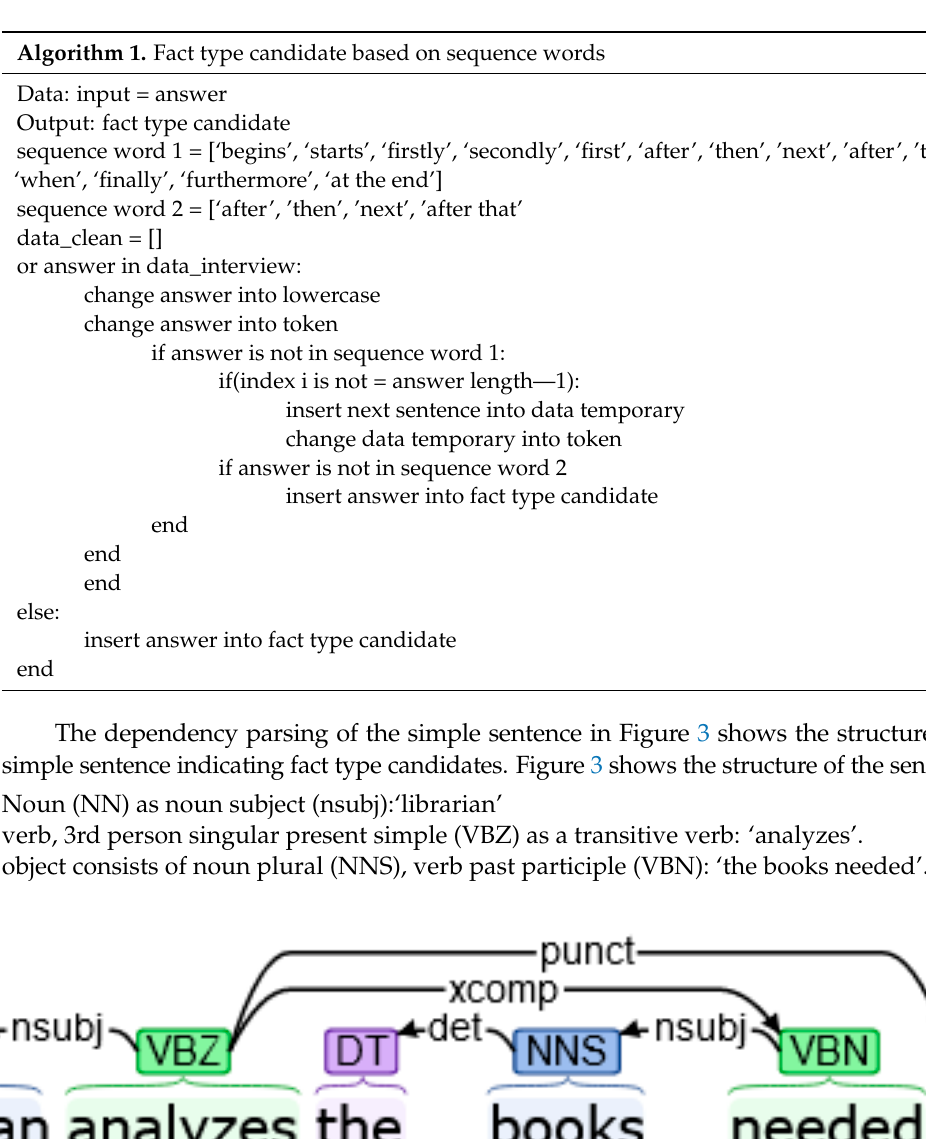
Algorithm 1. Fact type candidate based on sequence words